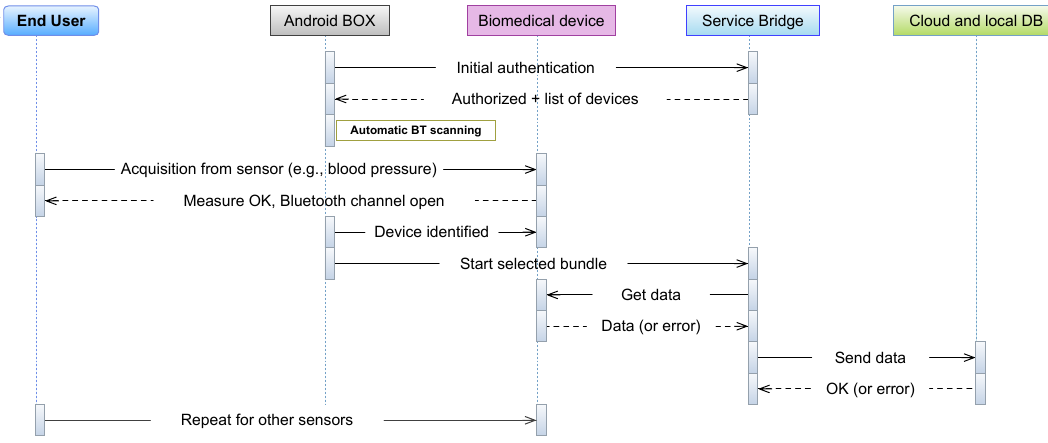
Figure 8. Modified user interaction with the Health@Home